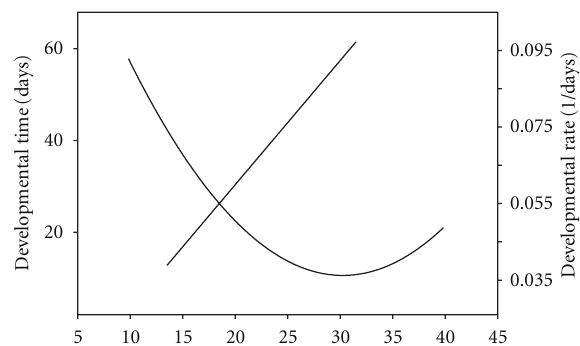
Figure 1: Typical response and temperature e ff ect on the devel- opmental time ( y = 115 . 5 − 6 . 9 x + 0 . 1134 x 2 ) of an insect (i.e., pupal stage of G. molesta ) and respective linear relationship between temperature and developmental rate according to the linear model ( y = 0 . 041 x − 0 . 0412, T min = 10 ◦